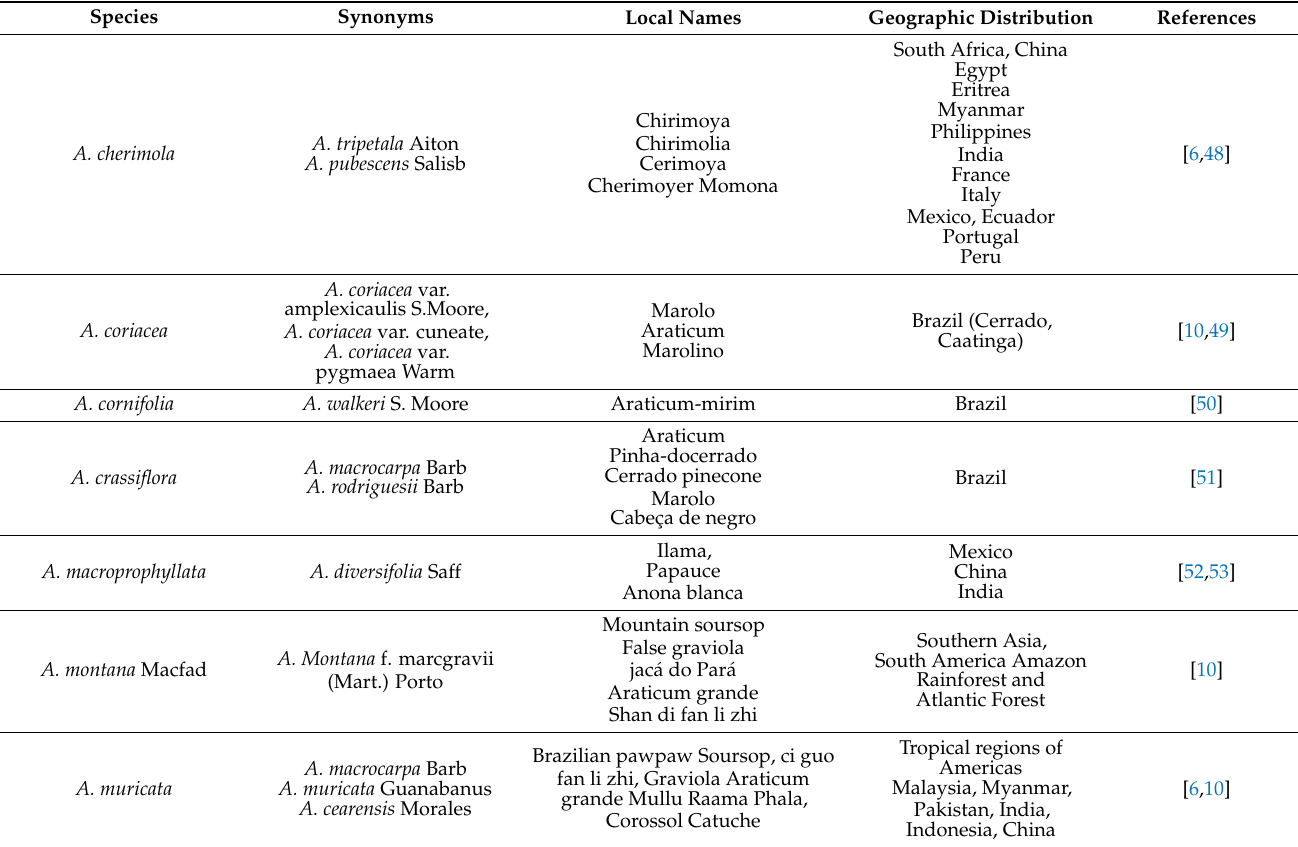
Table 4. Botanical information of some Annona